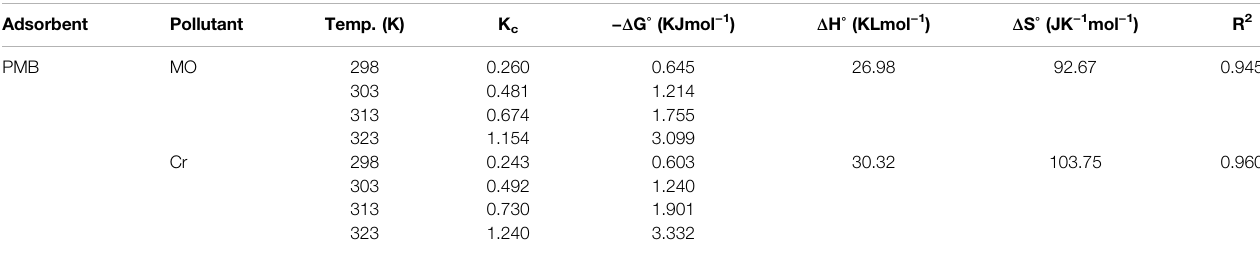
TABLE 4 | Thermodynamic parameters of pollutants onto the poultry manure-derived biochar. Adsorbent